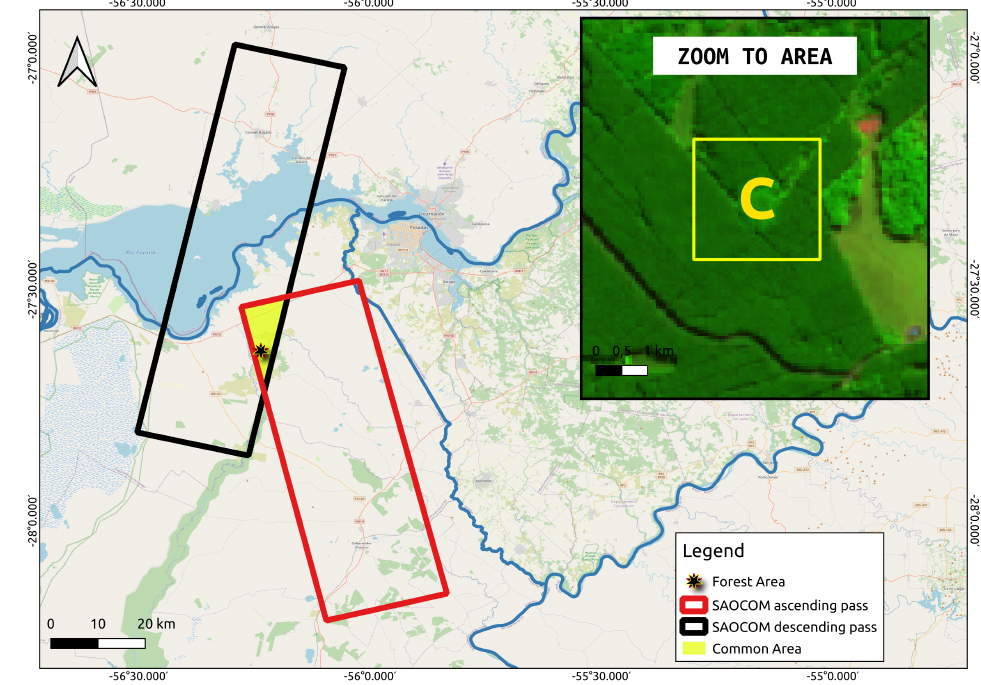
Figure 7. Area common to the ascending and descending passes used to compare the interferometric coherence (highlighted in yellow). The zoom shows the forested pixels, region C , which is also indicated on Figure 2a.